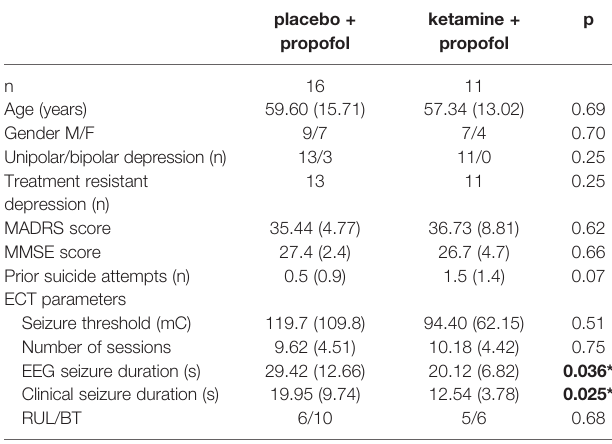
TABLE 1 | Clinical and sociodemographic characteristics of patients with major depressive